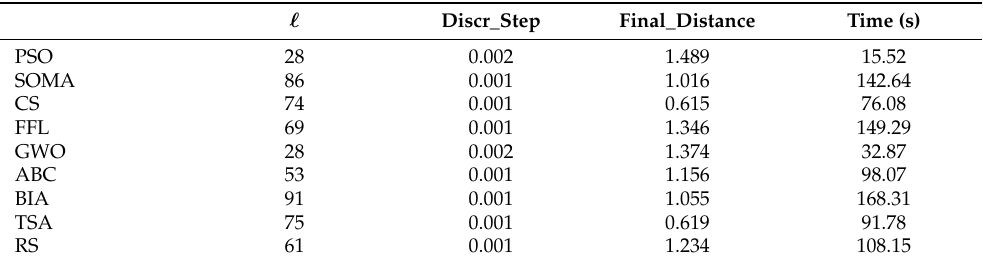
Table 13. The mean results for Function f 5 for 50 runs of evolutionary algorithms with a value of maxFES = 2500.